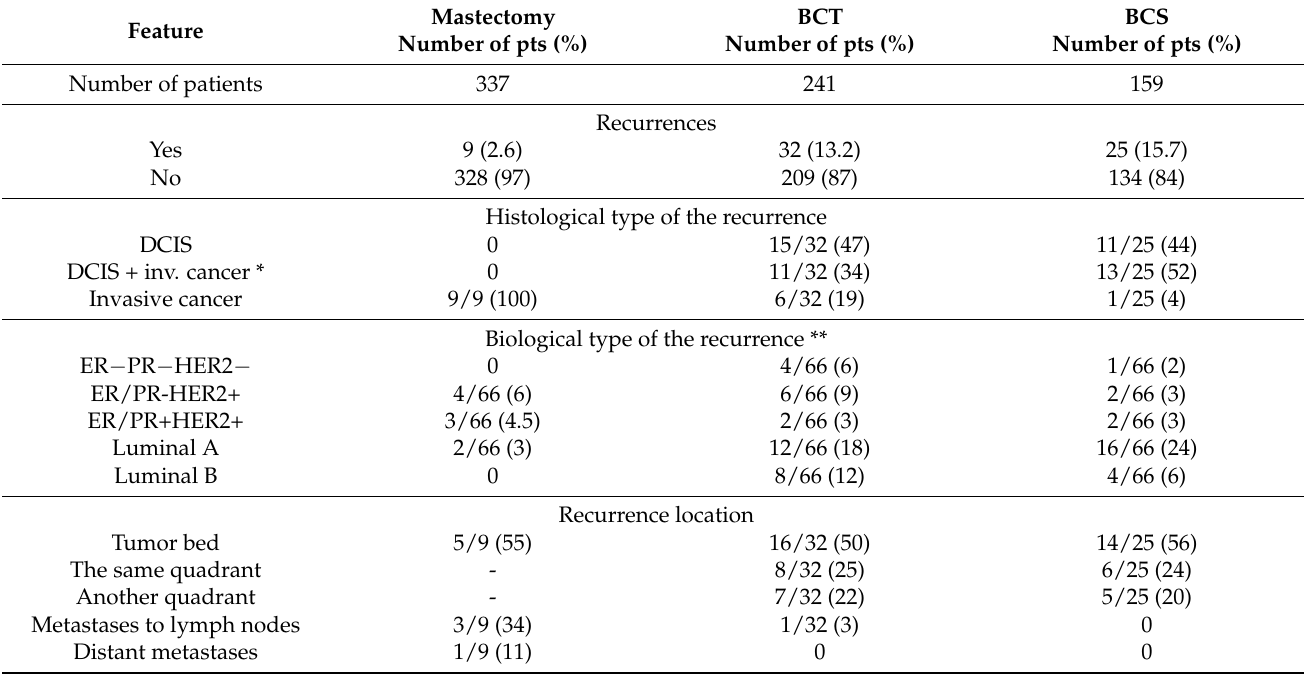
Table 3. Pooled characteristics of 66 recurrences, with subdivision according to the method of